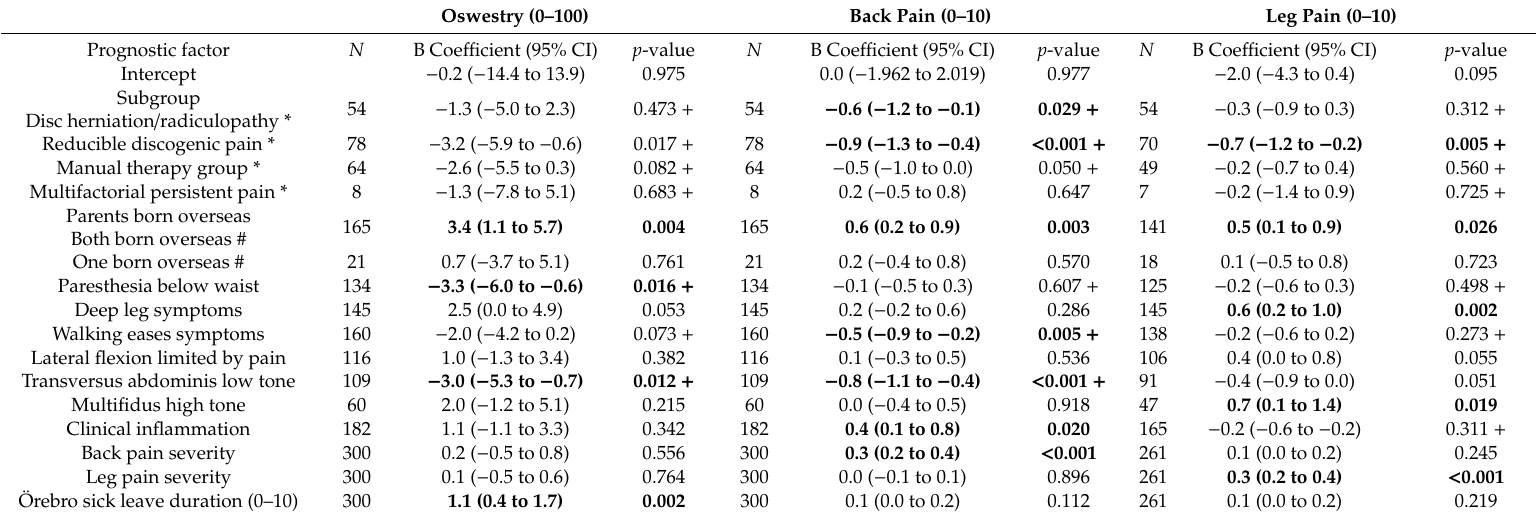
Table A1. Prognostic factors for Oswestry, back pain and leg pain obtained from the multivariate